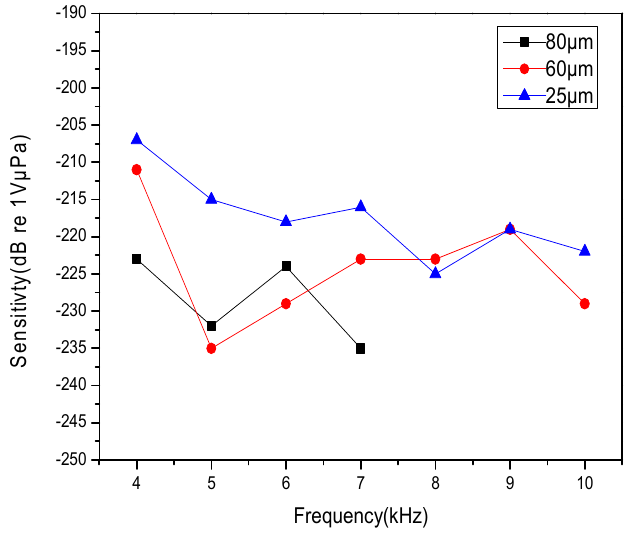
Figure 10. The sensitivity curves of fiber grating hydrophone versus the acoustic wave frequency in three different fiber diameters.